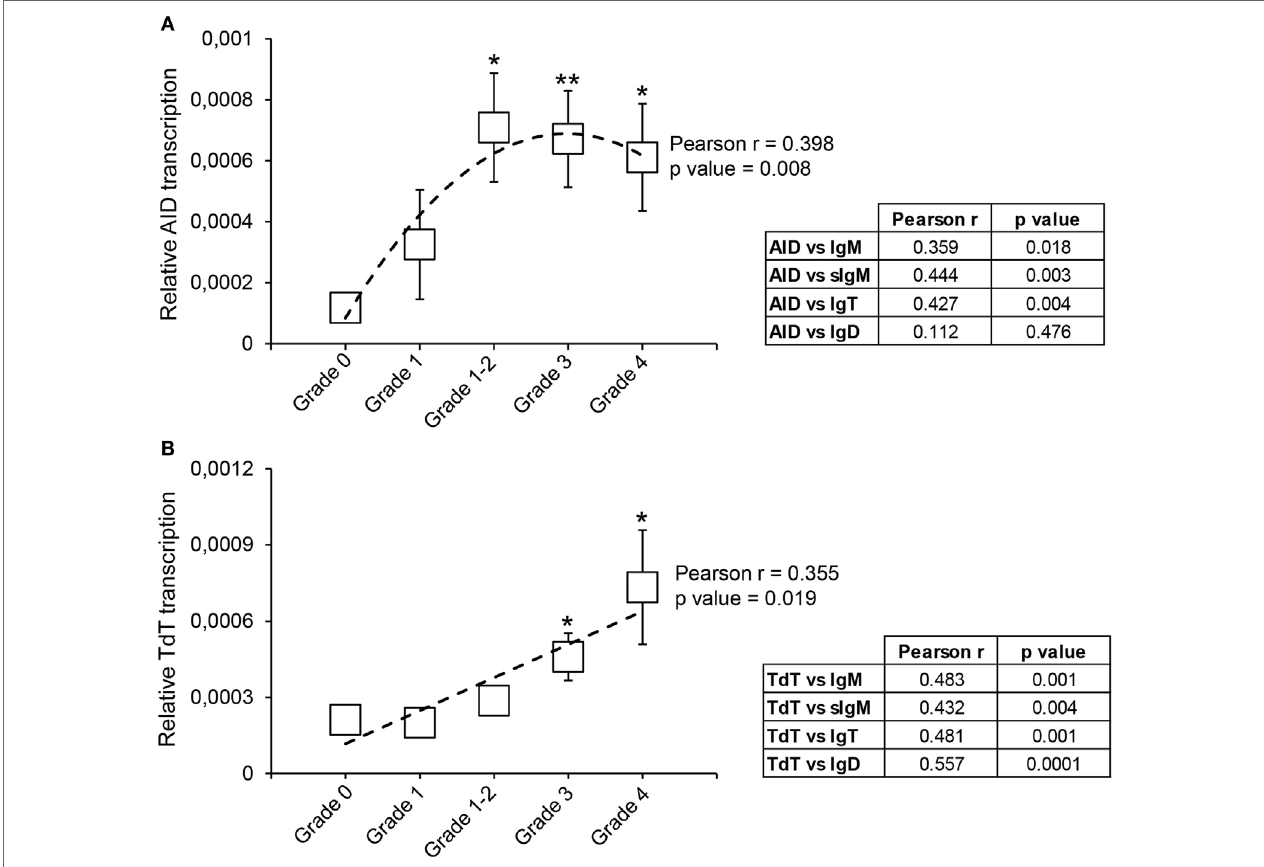
FigUre 7 | Transcriptional regulation of activation­induced deaminase (AID) and terminal deoxynucleotidyl transferase (TdT) during proliferative kidney disease. Transcriptional levels of AID (a) and TdT (B) were evaluated by real­time PCR in kidney samples classified according to their swelling grade. Results are shown as the gene expression relative to the expression of an endogenous control (EF­1 α ) (mean ± SEM) (G0, n = 10; G1, n = 4; G1–2, n = 7; G2, n = 11; and G3, n = 9). Statistical differences between control and infected groups (analyzed with a two­tailed Student’s t ­test) are shown as * P < 0.05 and ** P < 0.01. A polynomic or linear regression is also shown (dotted line) to reveal the correlation between the expression of specific genes and the progression of the pathology, together with the Pearson product­moment correlation coefficient ( r ) and the statistical significance of the correlation ( P value), which are indicated in the plots. Pearson product­moment correlation coefficient ( r ) and statistical significance of the correlation ( P value) between AID (a) or TdT (B) transcription with the transcription of immunoglobulin (Ig) M, secreted IgM (sIgM), IgT, and IgD are included in the adjacent tables